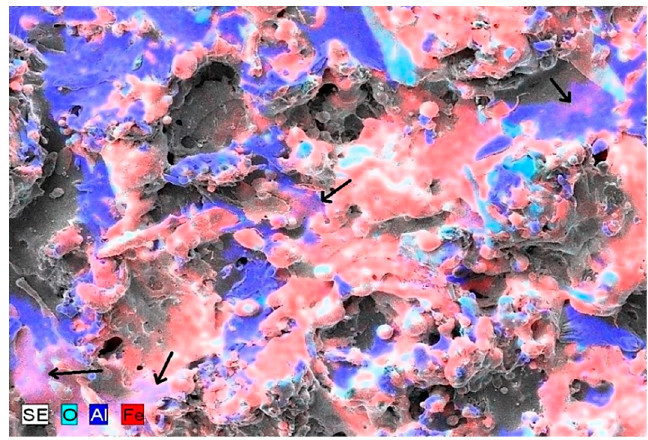
Figure 10. Map of the distribution of the chemical components present on the surface of the coating.